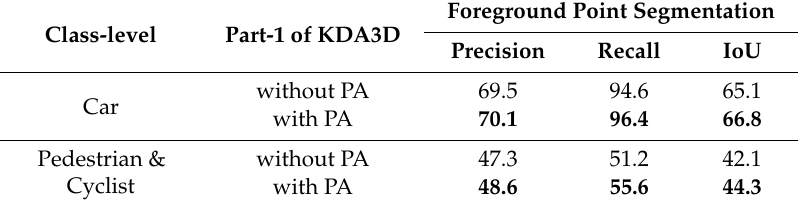
Table 5. KDA3D’s foreground point segmentation performance. IoU is used as the primary accuracy metric. All the values in this table are in percentages. The method in the second/fourth row is KDA3D’s final choice.